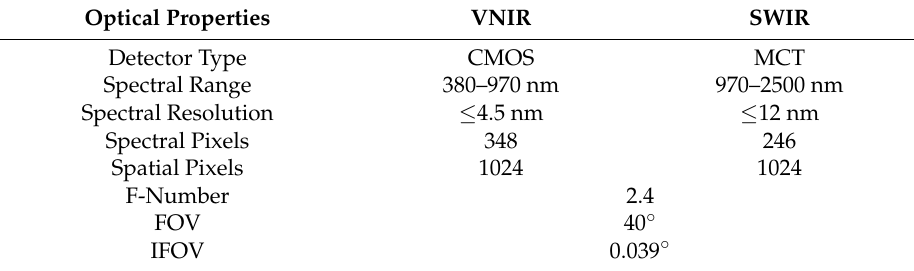
Table 1. Optical properties of the AisaFenix 1K hyperspectral imaging spectrometer.